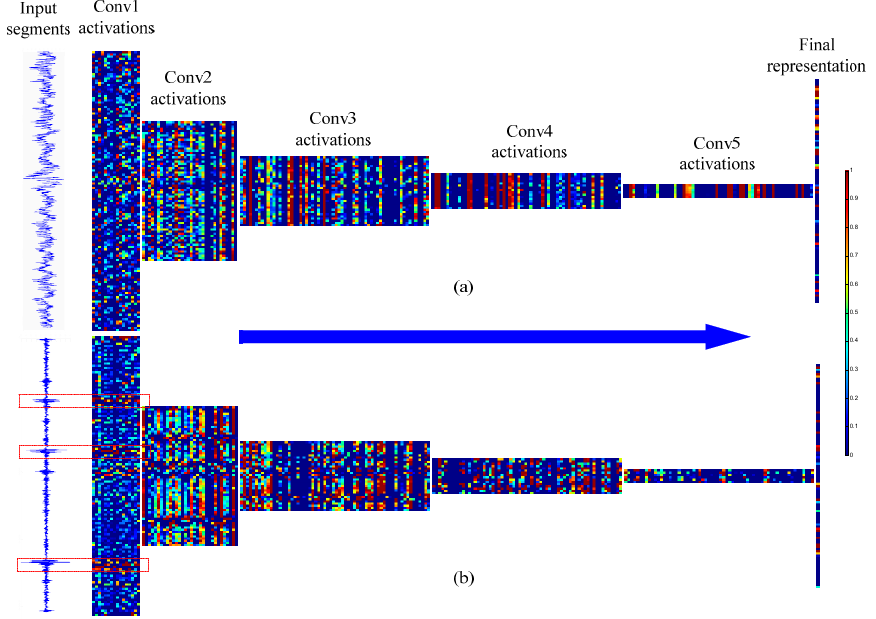
Figure 15. Visualization of all convolutional neuron activations in WDCNN for ( a ) a segment of normal vibration signal and ( b ) a segment of fault signal (inner race fault with 0.014-inch fault diameter). Red represents an activation of maximum, while blue means the neuron is not activated.